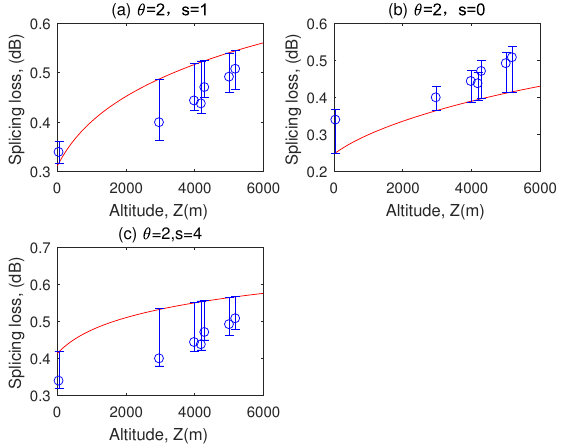
Figure 12. Splice loss versus angular tilt and lateral offset, when the inclination angle θ is 2°, the axial offset s is different, the red solid line represents the results obtained from the proposed model, and the vertical line with ” ◦ ” represents the experimental data in the environment of high altitude. The fusion experiments have been carried out at seven locations with different elevations respectively: 53 (plain), 2980, 4000, 4200, 4300, 5020, and 5200 m. After slight modification of the model, ( a ) s = 1 µ m; ( b ) s = 0 µ m and ( c ) s = 4 µ m when θ = 2 ◦